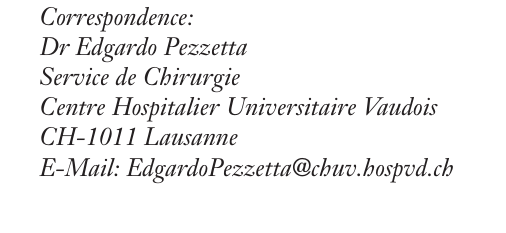
Figure 4 Chest X-ray showing stage I left lower lobe NSCLC in a patient with severe hetero- geneous emphysema submitted to apical segmentectomy of the left lower lobe. Preoperative and postoperative FEV 1 and RV were 0.82 L (34%), 2,74 L (150%) and 0,84 L (34%), 3,28 L (185%) respec-